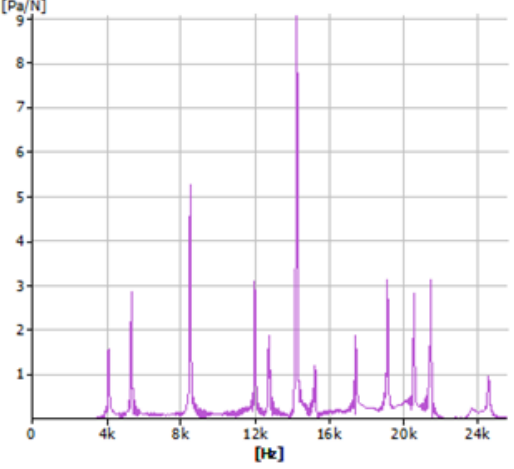
Fig. 5. Sound spectrum of the undamaged turbine blade no. 3